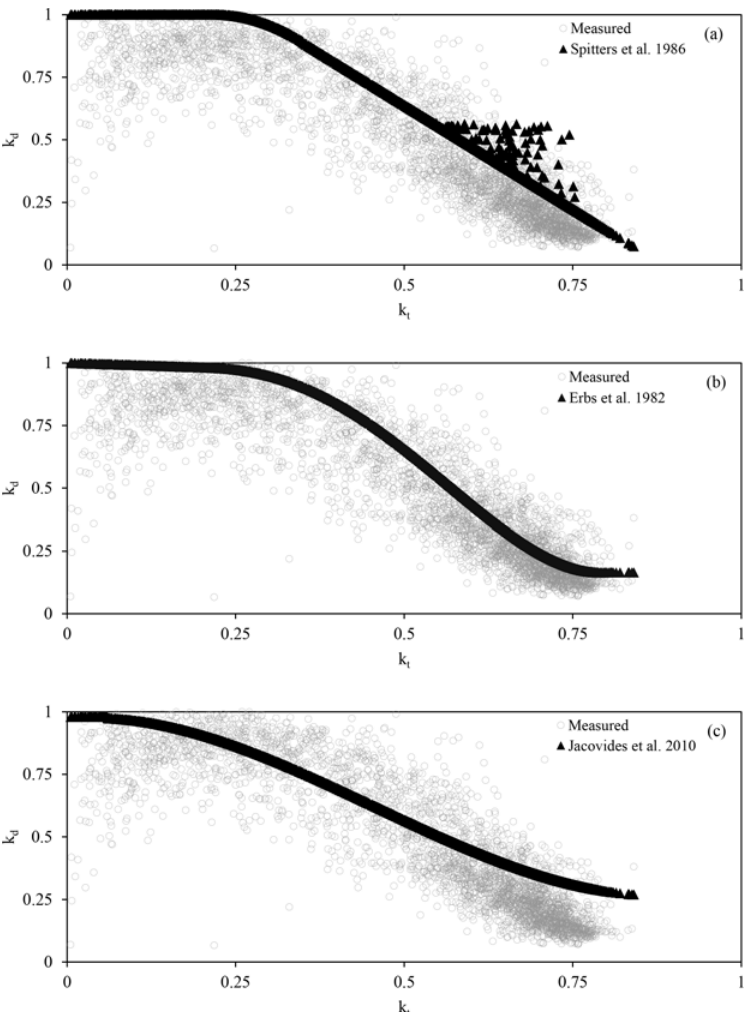
Figure 5. Relationship between clearness index (k t ) and ratio of diffuse-to-global radiation (k d ) for observed values plus 3 modeling approaches. a) Spitters et al. 1986 b) Erbs et al. 1982 c) Jacovides et